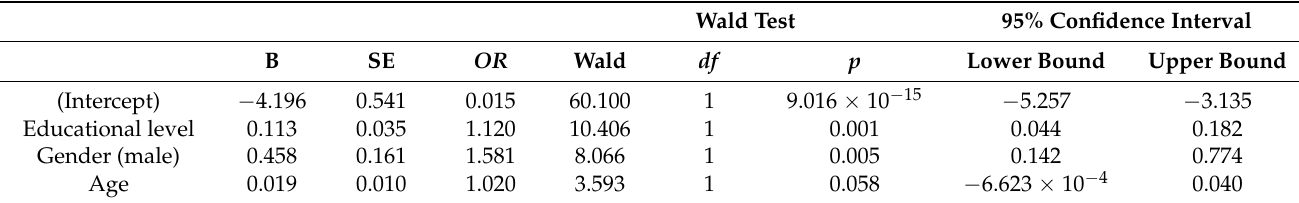
Table 3. Output of multiple logistic regression model entering gender, age, educational level, and dating app use (non-user vs. former user vs. active user) as predictors for drinking alcohol